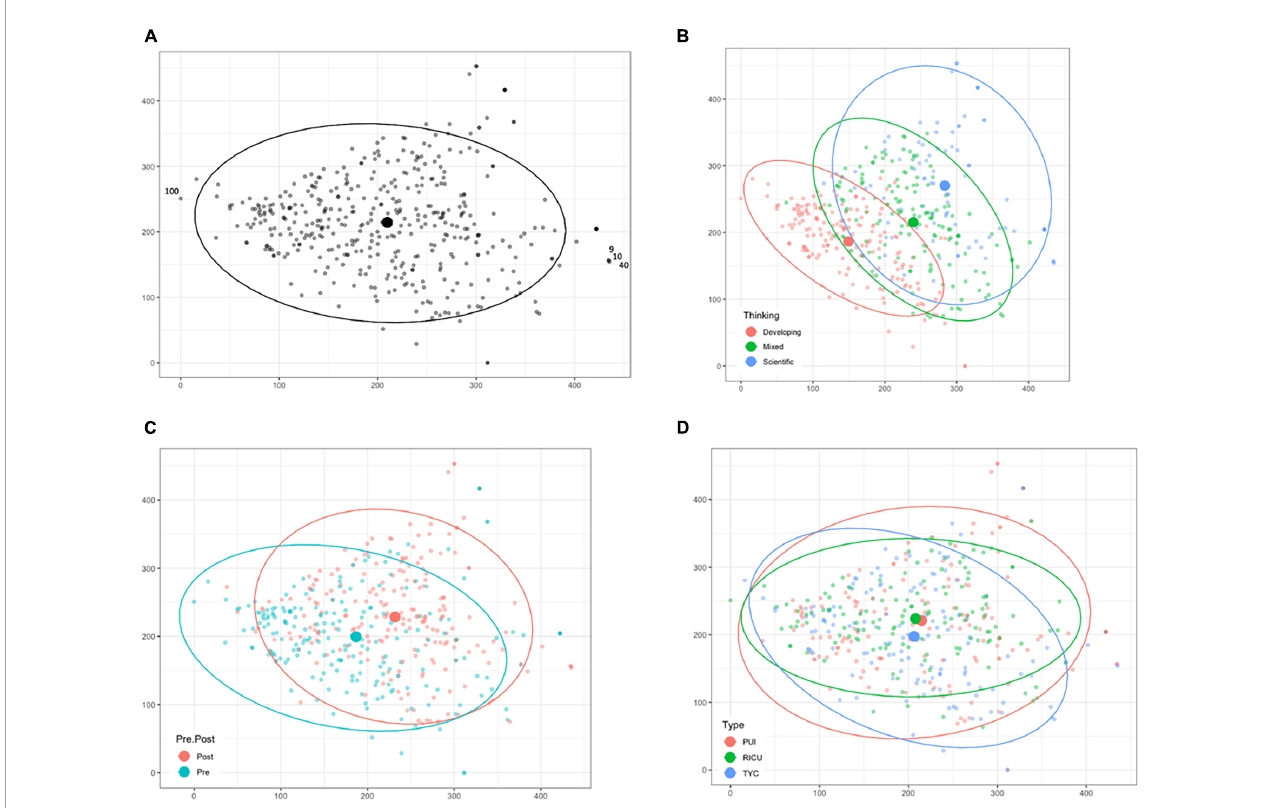
FIGURE3 Detrended Correspondence Analysis (DCA). DCA was performed without any data transformation. The graphs represent 416 responses after the removal of responses 35 and 78. (A) The ordination was graphed with select responses numbered for discussion in the Results. Grouping variables including (B) Thinking, (C) Timing, and (D) Type were overlaid to compare between groups. Centroids of a given grouping variable are represented as filled circles. Ellipses are the 95% multivariate t-distribution confidence of each categorical